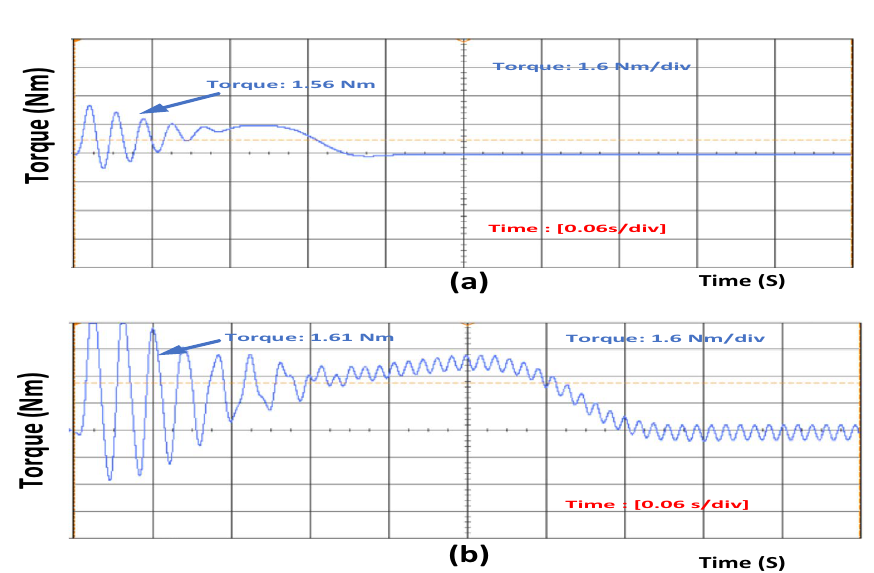
Figure 5. ( a ) Torque of the induction motor in healthy condition. ( b ) Torque of the induction motor in faulty